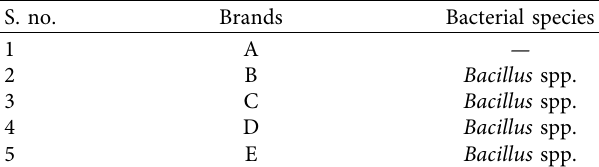
Table 5: Isolation of